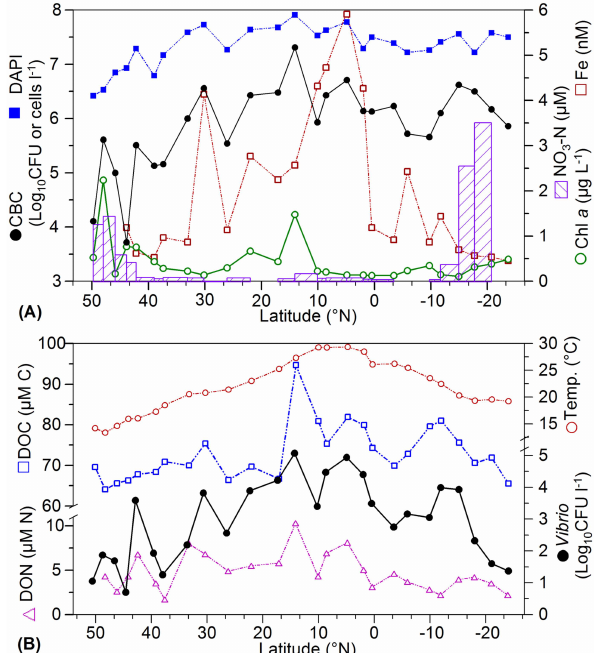
Fig. 2. Fluctuations in bacterial populations and important bio- geochemical parameters in surface (0–10m depth) water samples. (A) Changes in culture independent DAPI counts and cultivable bacterial counts (CBC) in comparison with changes in NO − and chlorophyll- a (Chl- a) . (B) Changes in cultivable Vibrio popula- tions in comparison with temperature (Temp.), dissolved organic C (DOC) and N (DON). Average values of bacteriological (triplicate) and biogeochemical parameters (quadruplicate) are